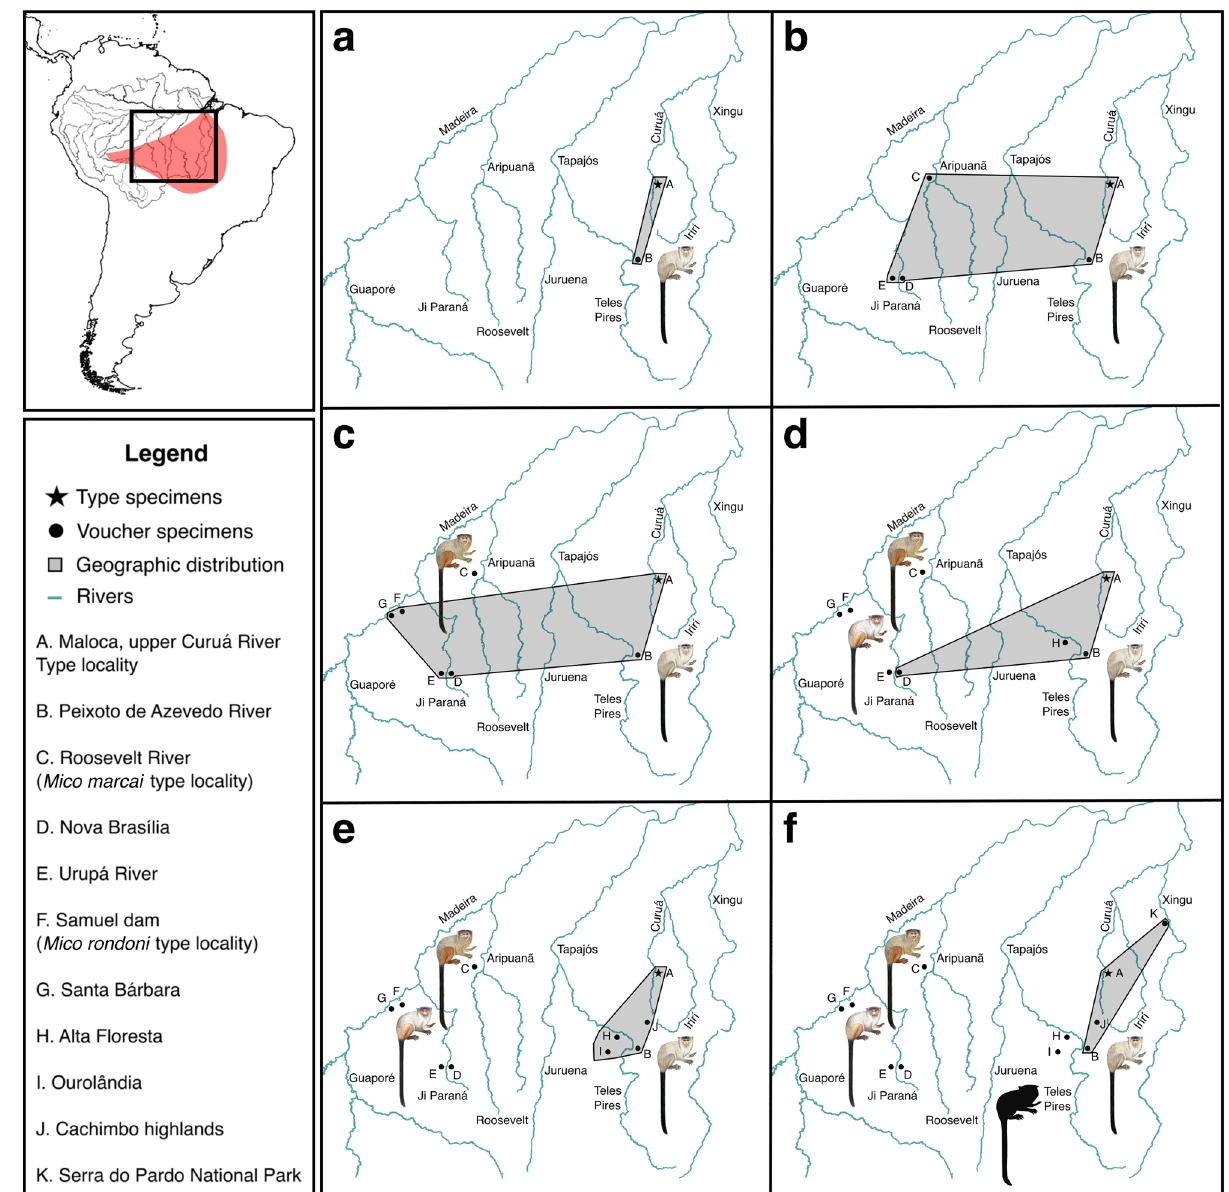
Figure 1. History of hypotheses on the geographical distribution of Mico emiliae according to past taxonomic and phylogenetic studies. The outer map of South America shows the boundaries of Amazonia biome with main riverine configuration in black and the arc of deforestation in red. The grey area in the inner maps shows the geographical distribution of M. emiliae : (a) 1920–1990: M. emiliae as either valid species, invalid species, or subspecies of M. argentatus 12–18 ; (b) 1991–1992: a valid species occurring on Tapajós–Xingu, Guaporé–Ji-Paraná and Ji-Paraná–Aripuanã interfluves 19 ; (c) 1993–2001: description of M. marcai for part of the Ji-Paraná– Aripuanã interfluve, and M. emiliae as a subspecies of M. argentatus with occurrence on the three interfluves of b 20 ; (d) 2002–2010: description of M. rondoni for part of the Guaporé–Ji-Paraná interfluve and M. emiliae as a valid species occurring on the Juruena–Teles Pires, Ji-Paraná–Aripuanã and Tapajós–Xingu interfluves 21 ; (e) current hypothesis supported by taxonomic studies 21,22 ; (f) hypothesis proposed since 1993 by A. Rylands and colleagues 11,23–25 (see Supplementary Table S2 for localities coordinates). Illustrations: Stephen